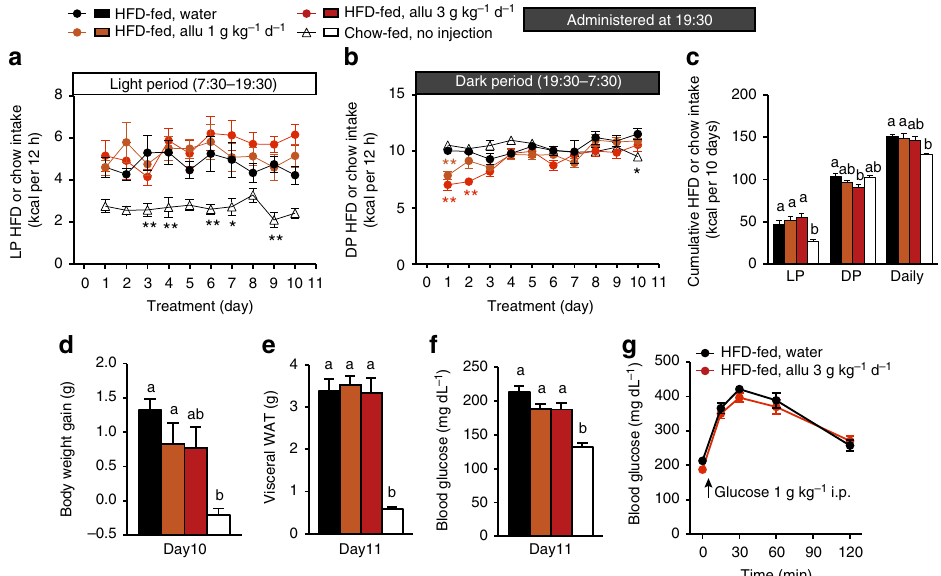
Fig. 8 DP D -allulose administration fails to ameliorate LP-hyperphagia, obesity and glucose intolerance. Effects of subchronic p.o. administration of Allu (1 or 3 g kg − 1 ) once daily at DP onset (19:30) for 10 days in HFD-fed obese mice (HFD-fed). Lean C57BL/6J fed standard chow (Chow-fed) without administration was the control for hyperphagic obesity. Time course of LP ( a ) and DP HFD intake ( b ), and cumulative HFD intake for 10 days ( c ). Body weight gain ( d ), visceral white adipose tissue (WAT) ( e ), and basal blood glucose level ( f ) in mice fasted 4 h at Day 10. Visceral WAT included mesenteric, perirenal and epididymal fat ( g ). n = 6 – 7. The blood glucose following i.p. injection of glucose in HFD-fed mice treated with water and 3 g kg − 1 day − 1 Allu ( g ). * p < 0.05 and ** p < 0.01 by two-way ANOVA followed by Tukey ’ s test vs. HFD-fed, water group ( a , b ). Different letters indicate p < 0.05 by one-way ANOVA followed by Tukey ’ s test ( c – f ). Error bars are